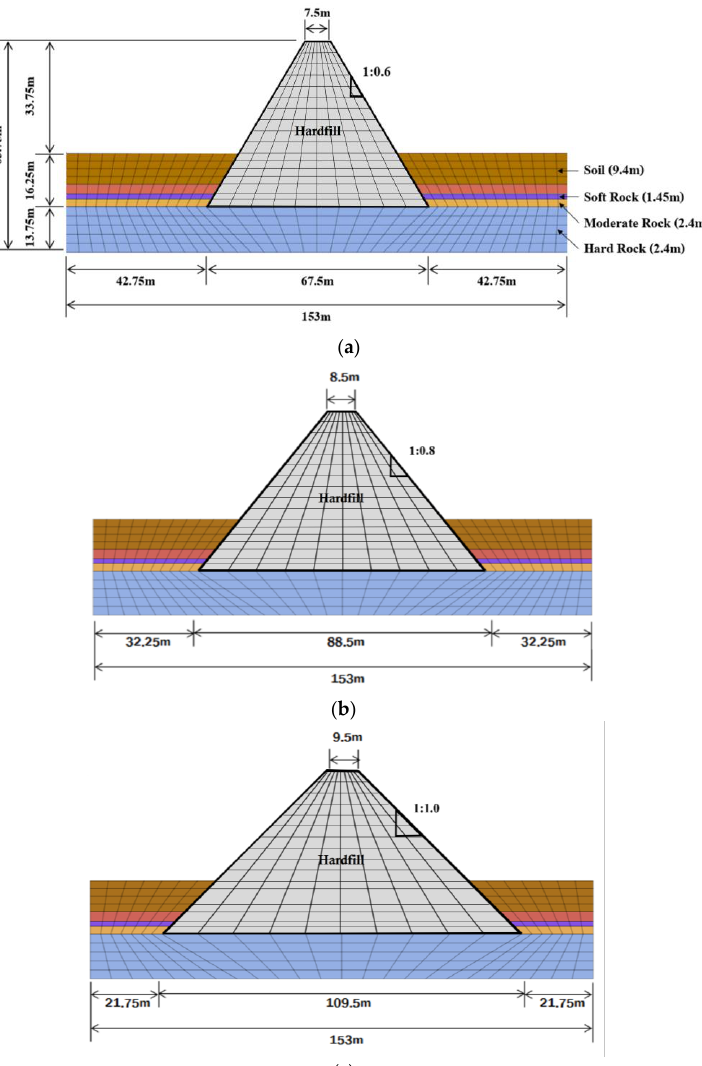
Figure 4. Cross-sections of dams for finite element (FE) analysis. ( a ) Dam slope gradient of 1:0.6 (vertical-to-horizontal ratio); ( b ) dam slope gradient of 1:0.8 (vertical-to-horizontal ratio); ( c ) dam slope gradient of 1:1.0 (vertical-to-horizontal ratio). Table 5. Finite element method (FEM) model parameters for the ground.